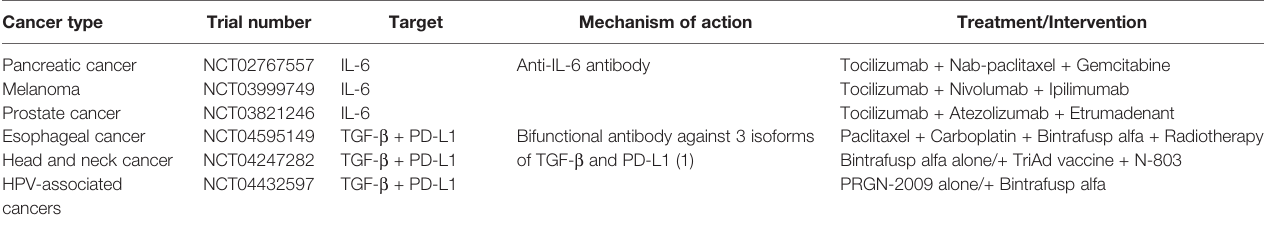
TABLE 2 | Clinical trials targeting CAF associated pathways involving IL-6 and TGF- b in different